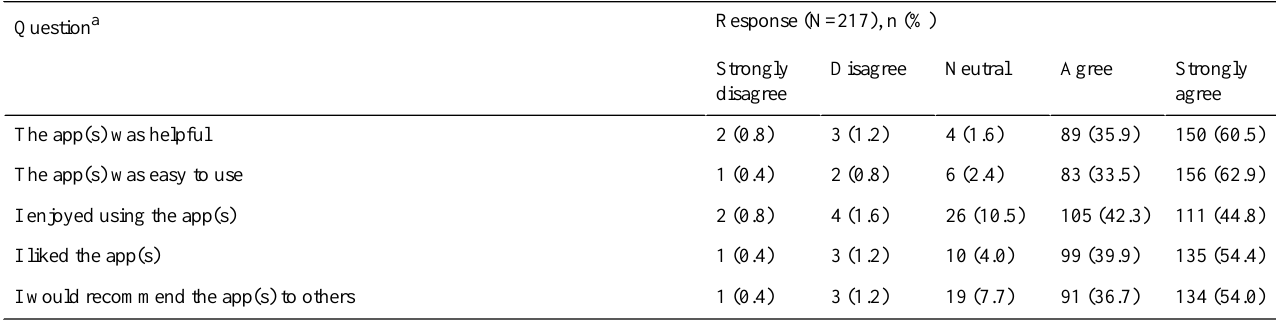
Table 4. Summary of participant responses to engagement questions.